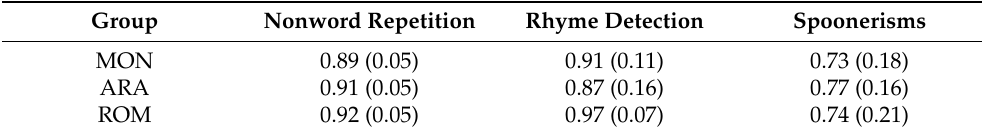
Table 2. Mean accuracy (SDs) of the three groups in the phonological tasks. Group Nonword Repetition Rhyme